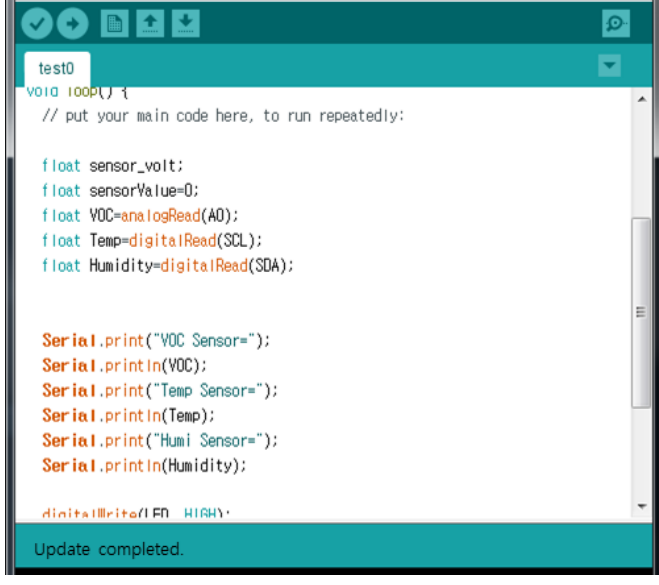
Figure 14. Coding screen for obtain sensing data using Arduino.